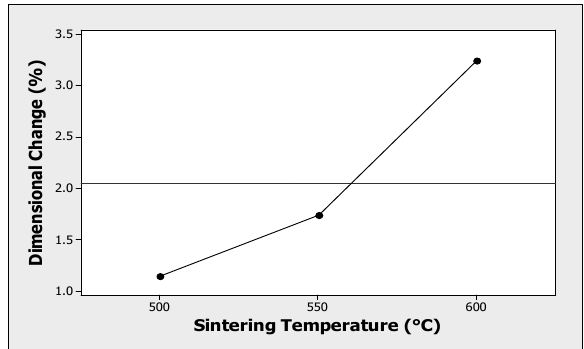
Figure 4. Effects of sintering temperature on the dimen- sional change of AZ31 magnesium alloy.